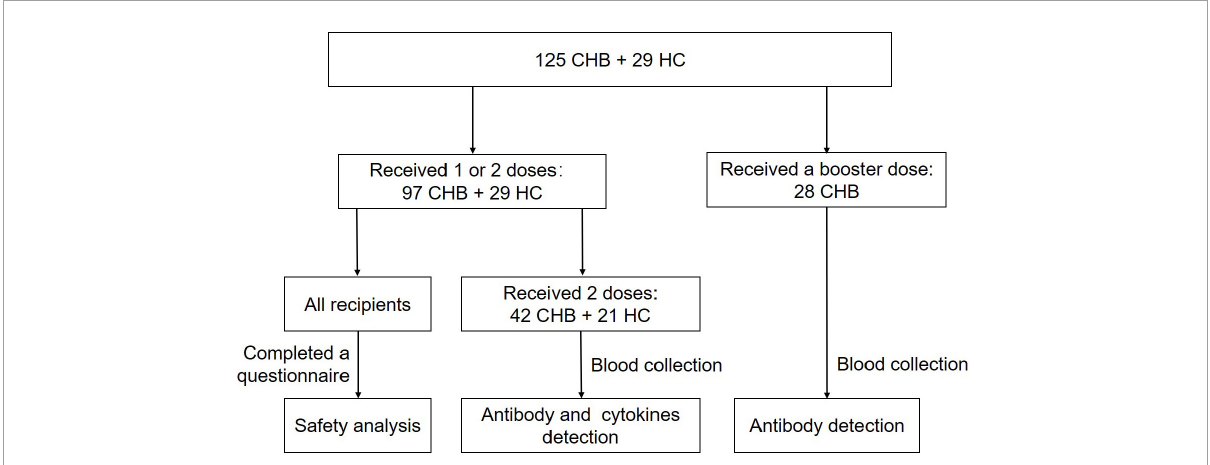
FIGURE1 Flow chart of recipients enrolled. A total of 125 patients with chronic hepatitis B (CHB) and 29 healthy controls (HCs) were enrolled in this cross-sectional study. Safety analysis was performed on 97 patients and 29 HCs, who received one or two doses. Serum antibody and cytokines from 42 patients and 21 HCs were collected more than 14 days after two doses and analyzed. Another 28 nucleos(t)ide analog (NA)-monotherapy patients who received an additional booster dose (the interval from the second dose was 6–7 months) were examined for antibodies more than 14 days after three